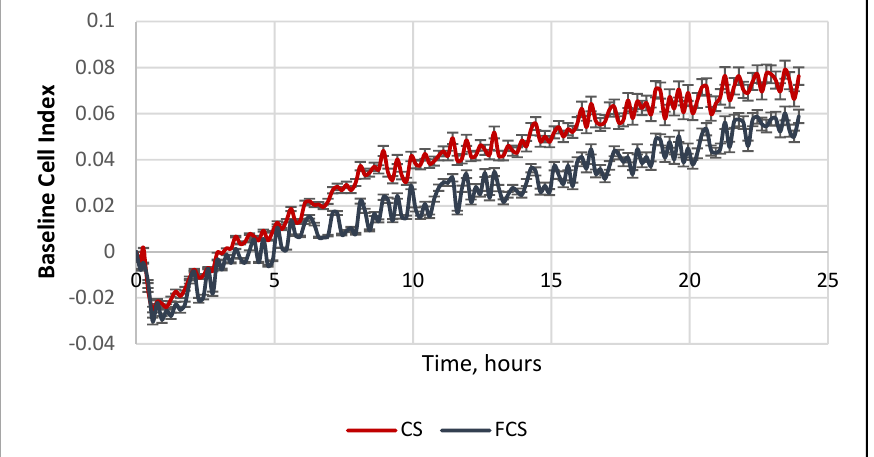
Figure 10. The effect of CS and FCS on the adhesion of mouse bone marrow cells (red— CS , blue— FCS ). The cell index of the CS and FCS groups is normalized to the control values.